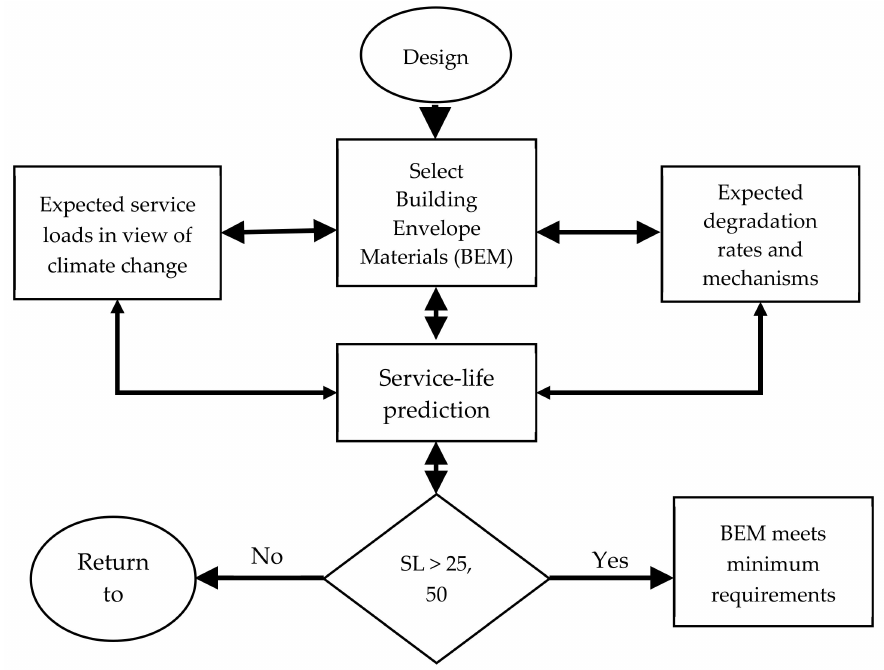
Figure 4. Steps to the selection of BEMs with SL greater than 25, 50